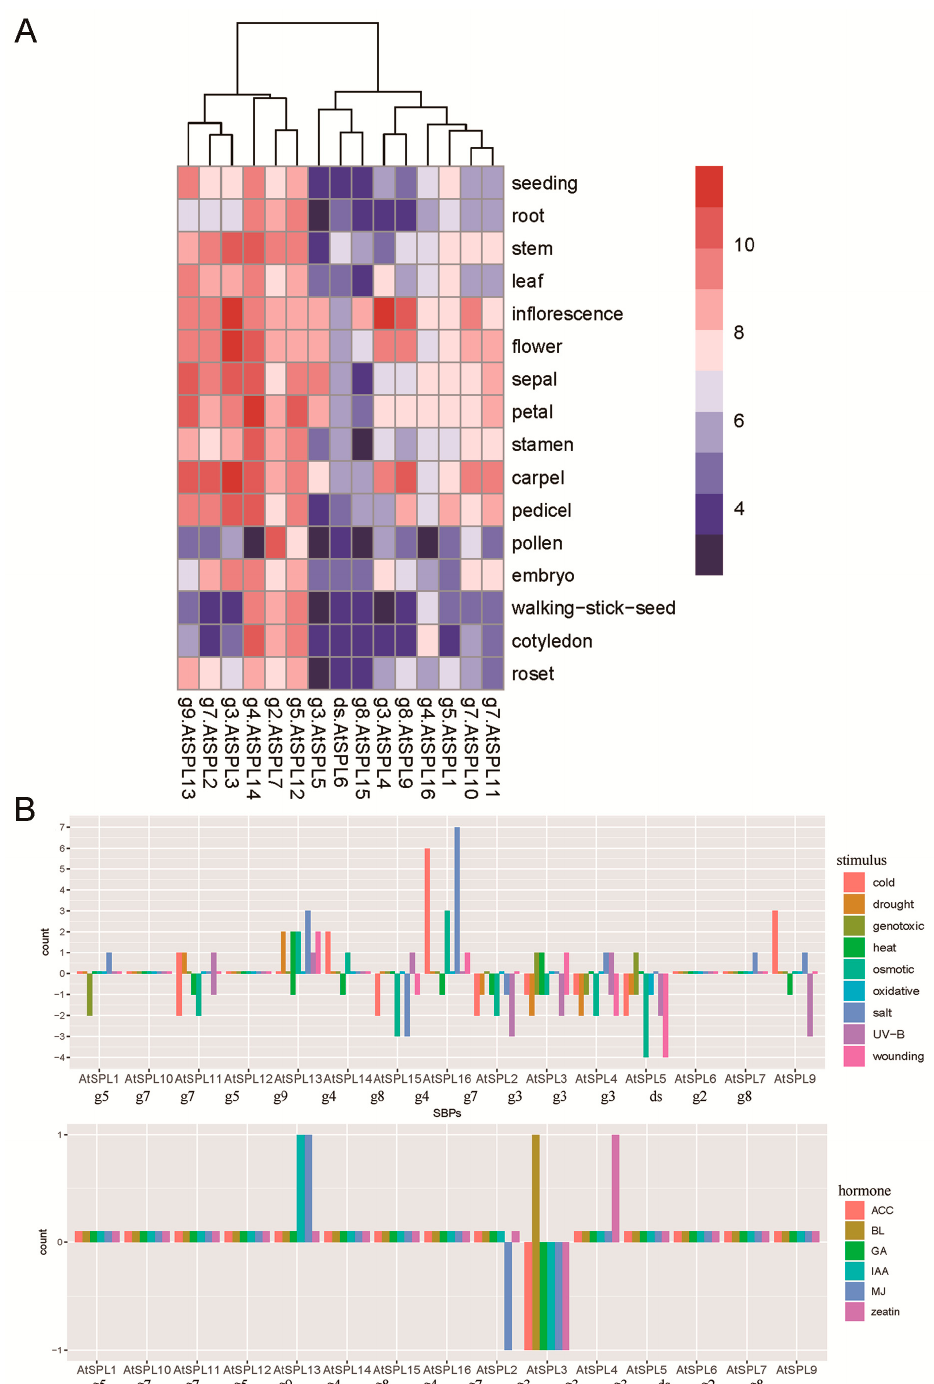
Figure 7. The expression profile of AtSPLs. ( A ) The tissue expression of AtSPLs. ( B ) The number of differential expressions of AtSPL genes in each stress treatment.